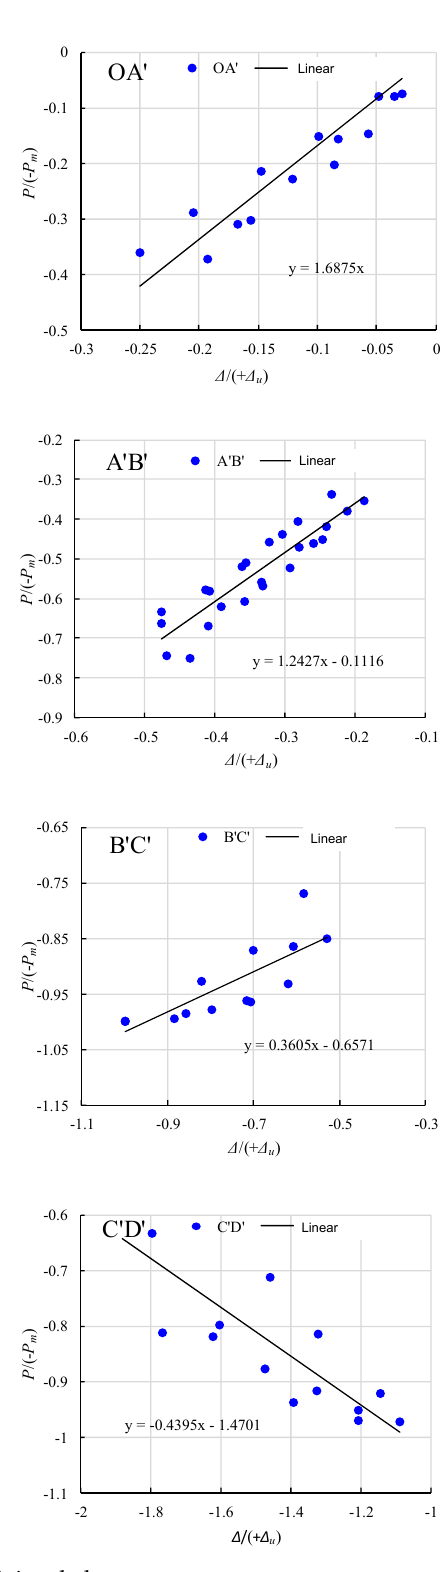
( b ) Each stage fitting process of exterior joint skeleton curve Figure 22. Fitting process of skeleton curve. Figure 22. Fitting process of skeleton Table 8. Linear equation and stiffness of each stage in skeleton curve model of interior joint.